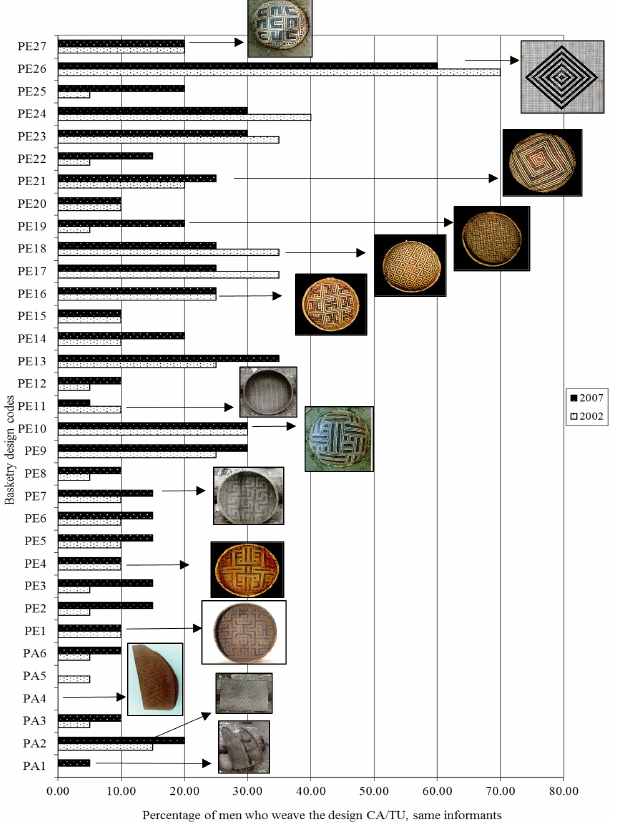
Fig. 4 . Comparison of the percentage of men capable of weaving basketry designs in 2002 and 2007, showing the impact of the action-research project Kaiabi Araa. Designs are coded according to the catalogue used for the semistructured interviews carried out with same men in two villages. Photos by: Simone Athayde, Georg Grünberg, and donations from The Museum of Cultures (Basel, Switzerland) and Museum of Archaeology and Etnography of Sao Paulo (MAE/USP).